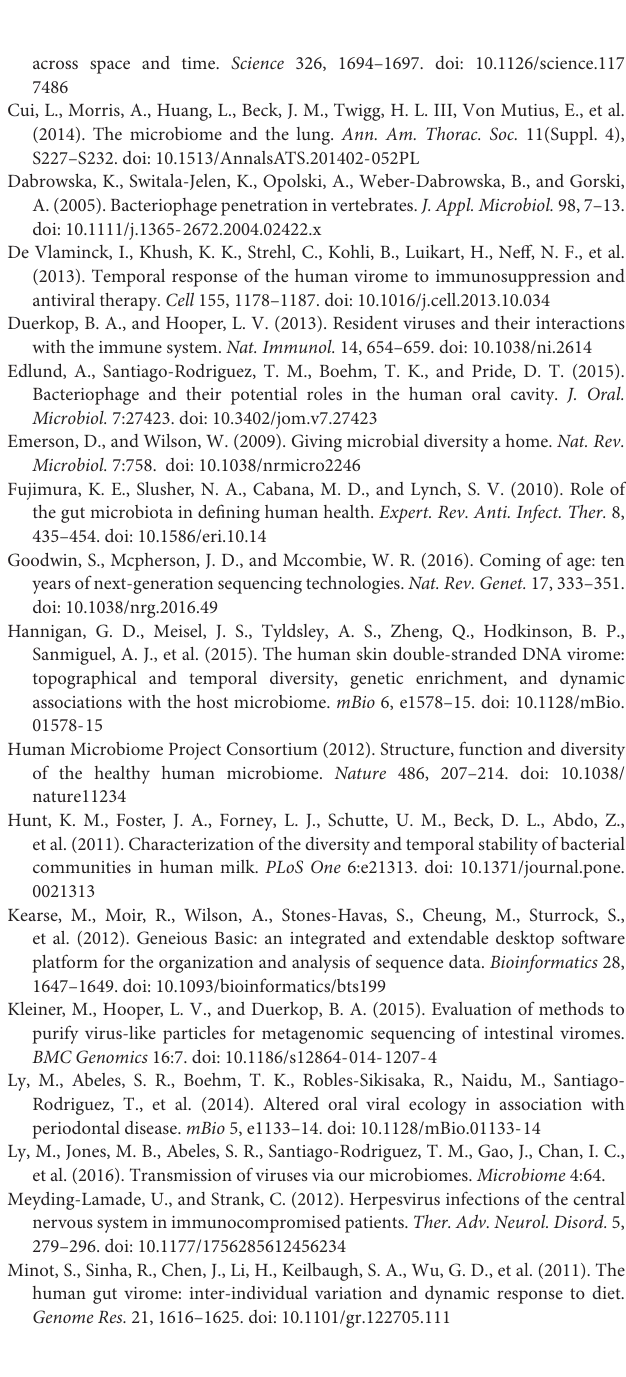
FIGURE S14 | Representation of beta-diversity based on Bray Curtis distances, shown in Principal coordinates analysis of the viral communities. The CSF specimens sequenced using semiconductor sequencing (pink circles) clustered similarly to those sequenced by Illumina (blue circles). Ellipses are drawn at 95% confidence intervals for sample type. TABLE S1 | Characteristics of study subjects/specimens. TABLE S2 | Contig metrics from study specimens. TABLE S3 | Contig metrics from CSF specimens. TABLE S4 | IMG/VR BLASTX homolog